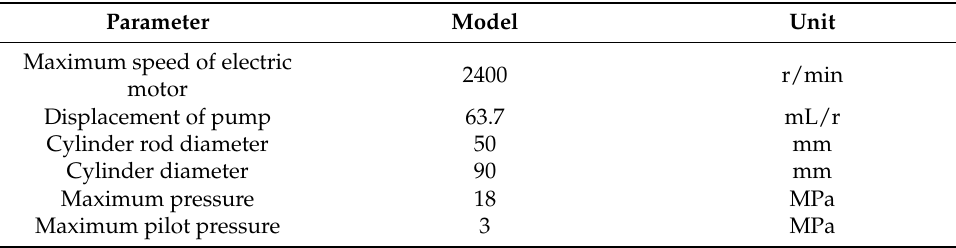
Figure 10. AMESim simulation model of the positive flow system based on variable speed. Table 1. Parameters of the key